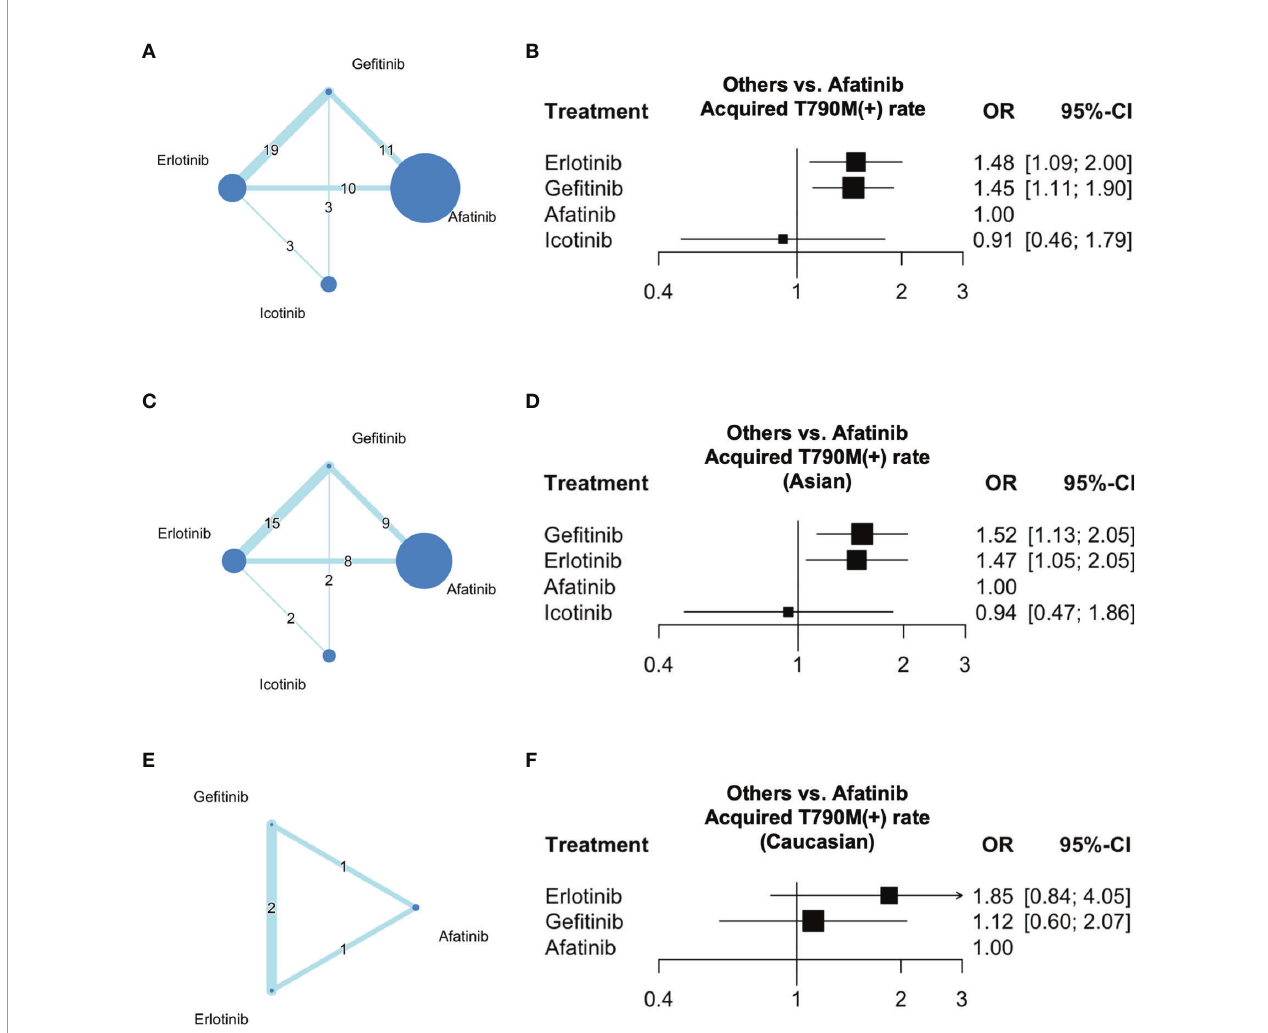
FIGURE 2 | Network of the comparisons and forest plot for the network meta-analysis. Networks of eligible EGFR-TKIs comparisons for outcomes of acquired T790M mutation rate for (A) all participants, (C) Asians, and (E) Caucasians. Forest plots of eligible EGFR-TKI comparisons for outcomes of acquired T790M mutation rate for (B) all participants, (D) Asians, and (F) Caucasians. Network: The size of the nodes corresponds to the number of studies for each treatment. The lines between nodes represent a direct comparison of the trials and the thickness of the lines linking nodes corresponds to the number of trials included.